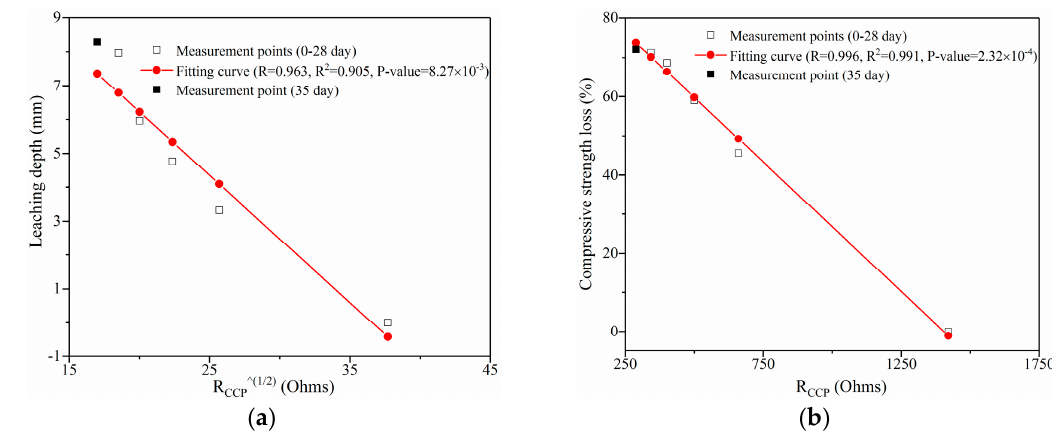
Figure 12. Prediction on leaching depth and compressive strength loss of G2 using R CCP : ( a ) leaching depth and ( b ) compressive strength loss. Note: the equations of the fitting curves of ( a ) and ( b ) are y = 13.750 − 0.376x and y = 92.841 − 0.066x, respectively. Table 6. Comparisons of measured results and predicted results for leaching depth. Leaching Duration Measured vs. Calculated Depth